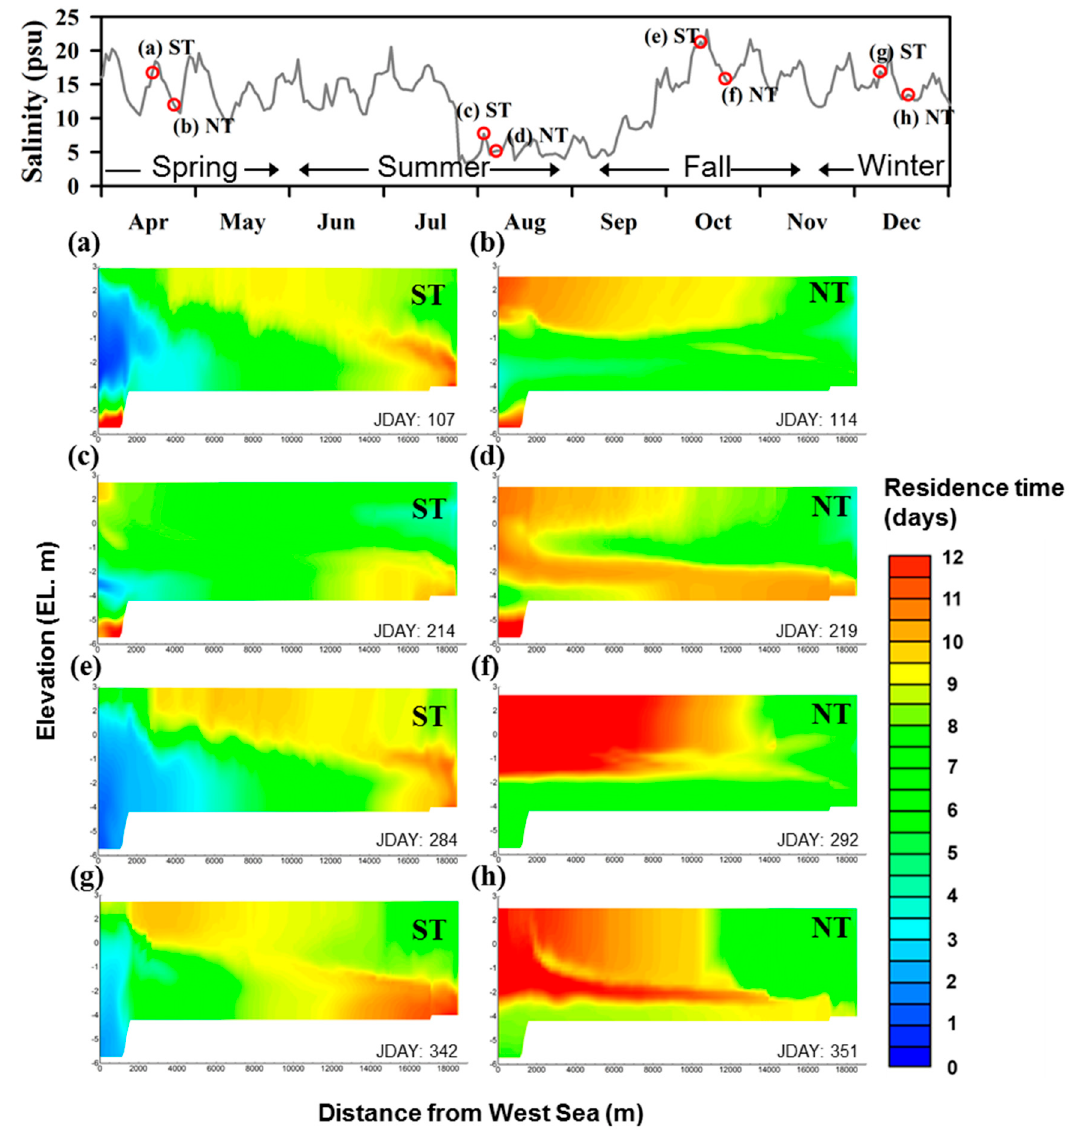
Figure 8. Spatial distributions of residence time in each season in GAW; ( a , c , e , g ) ST and ( b , d , f , h ) NT; ST: Spring tide, NT: Neap tide.